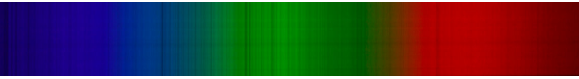
podge of effects. The coloured images of the lamps, each corresponding to a spectral line, overlap, creating a mix of spatial information and wavelength information that is not easily disentangled. A common solution is shown